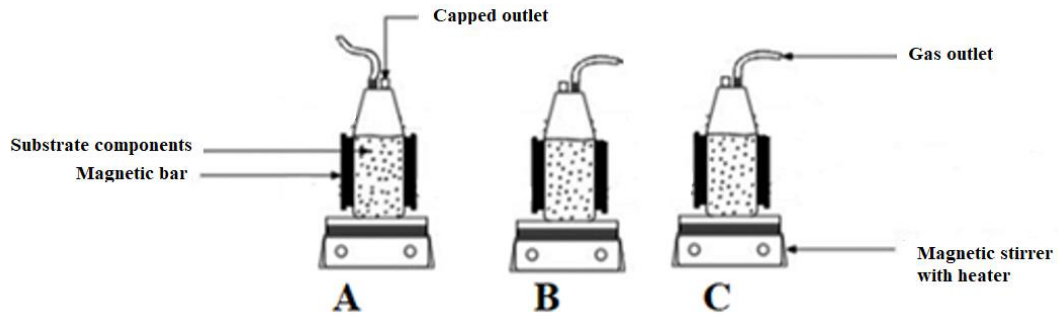
Figure 11. Magnetized biochemical methane potential (MBMP) setups; ( A ) with Alum; ( B ) with Ms and ( C ) Control without any nanomaterials.